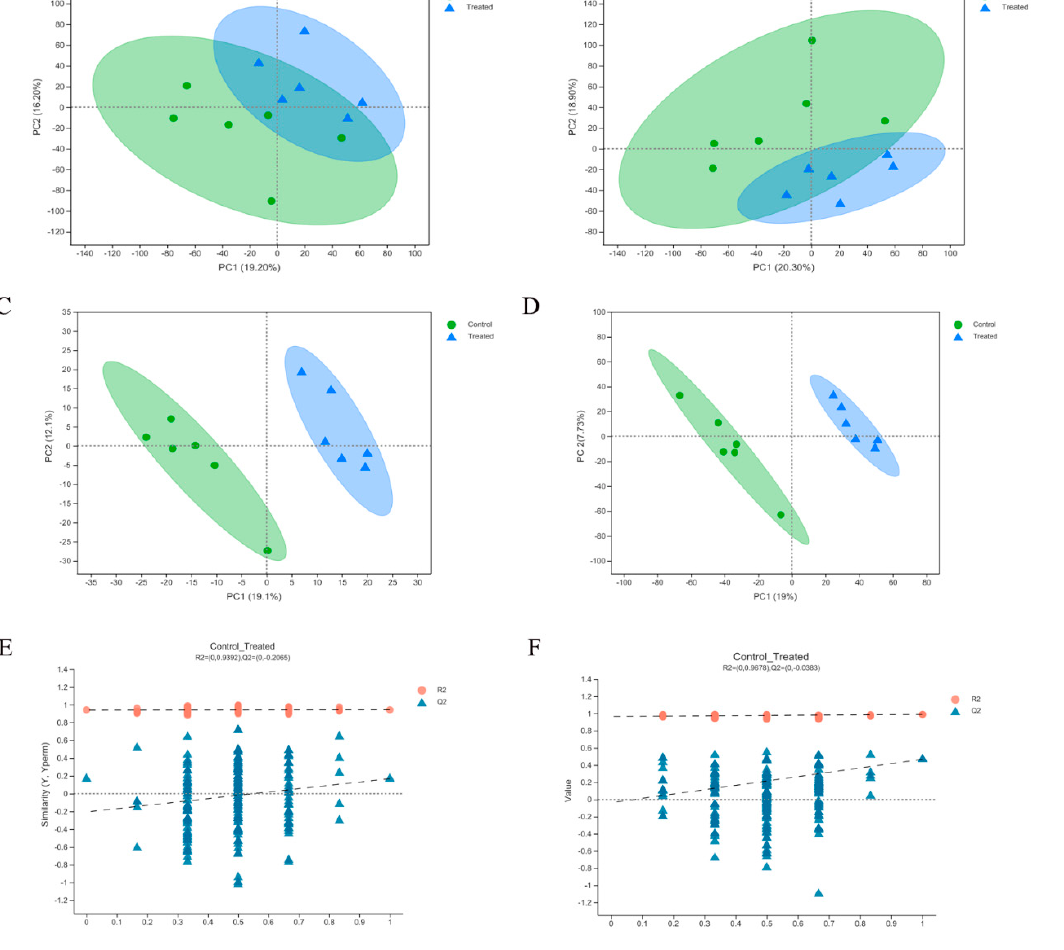
Figure 4. PCA scores of total samples under the positive ion mode ( A ) and negative ion mode ( B ), respectively ( n = 6). Partial least squares discriminant analysis (PLS-DA) with a 2D score plot of copper group and controls under the positive ion mode ( C ) and negative ion mode ( D ), respectively. Permutation analysis plotting R2 and Q2 from 200 permutation tests in the PLS-DA model, under the positive ion mode ( E ) and negative mode ( F ), respectively. Treated represented copper groups.